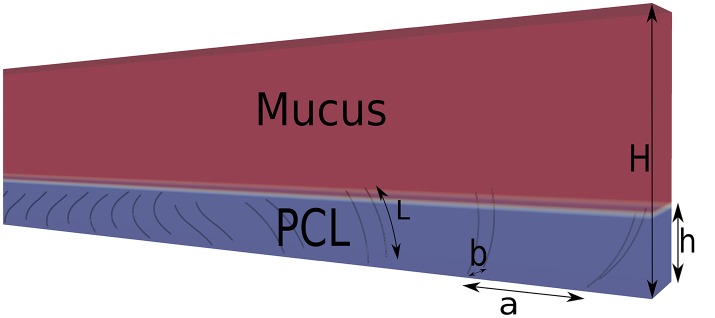
Schematic view of the domain. The length of the cilia is L, the cilia spacing in the x-direction is a = 1.44L, and in the y-direction is b = 0.4L. The ratio h/H is set to 0.26.